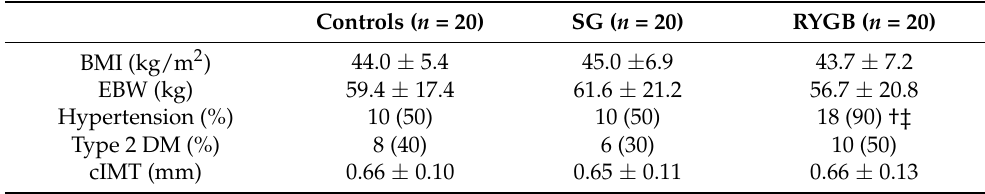
Table 1. Baseline anthropometric and metabolic characteristics of the men included in this